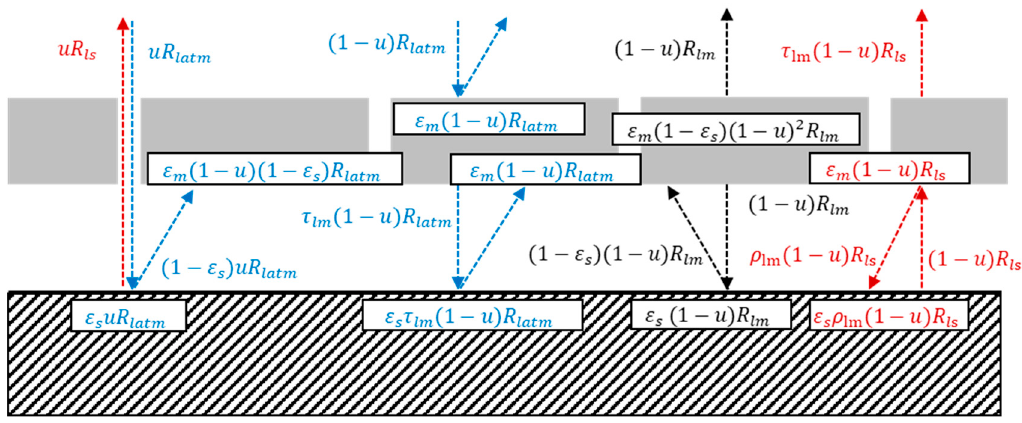
Figure 4. Schematic diagram of longwave radiation transmission, reflection, and absorption process emitted by the atmosphere (blue lines), the plastic film (black lines) and the soil (red lines).